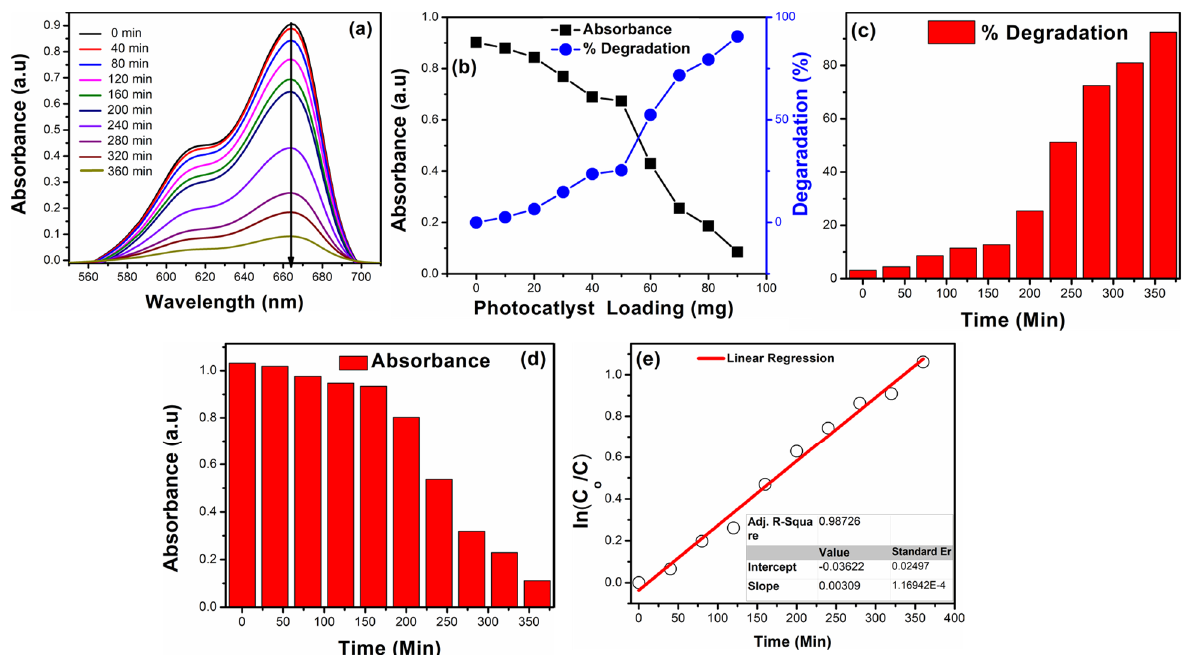
Figure 7. Dye photodegradation studies performed in 5 ppm methylene blue (MB) solution and by monitoring UV-ab- sorption curves after every 40 min interval under 1 sun visible light. In each step, 10 mg La 2 O 3 –CoO–g-C 3 N 4 nanocomposite was added to MB. ( a ) Photodegradation pattern of MB vs. time of exposure to 1 sun visible light. ( b ) Absorbance and % degradation profiles upon loading photocatalyst. ( c ) Degradation pattern of MB with respect to time. ( d ) Absorbance pro- file of MB upon addition of each increment of 10 mg La 2 O 3 –CoO–g-C 3 N 4 nanocomposite vs. time of visible light exposure. ( e ) Linear regression analysis shows a pseudo-first-order reaction on the surface of the La 2 O 3 –CoO–g-C 3 N 4 nanocomposite upon interaction with MB and visible light.